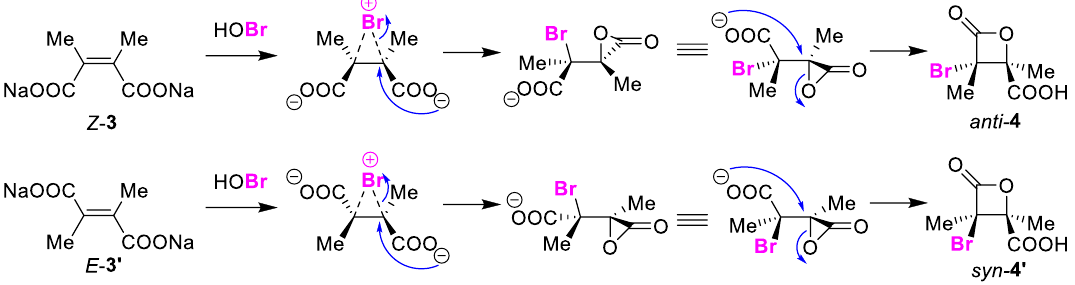
Figure 44. Early-reported stereoselective halo-lactonization of the sodium salts of dimethyl maleic acid Z - 3 and dimethyl fumaric acid E - 3′ .